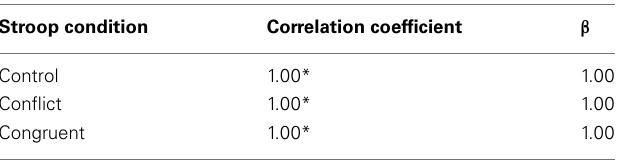
FIGURE 8 | Interference ratios for the four